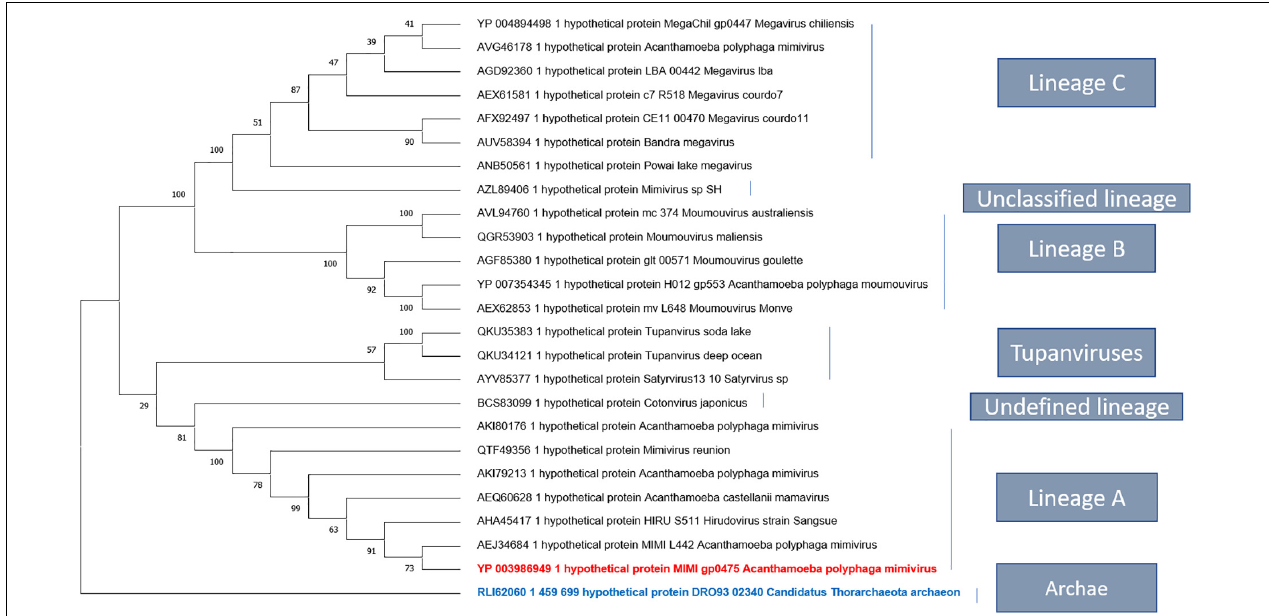
FIGURE 6 | Phylogenetic tree based on the amino acid sequences of mimivirus uncharacterized protein L442. The analysis was performed using maximum likelihood method (ML). The amino acid sequences were aligned using Muscle, and the tree was built using FastTree. Bootstraps below 50 were discarded. There were a total of 1,358 positions in the final dataset. Evolutionary analyses were conducted in MEGA X.